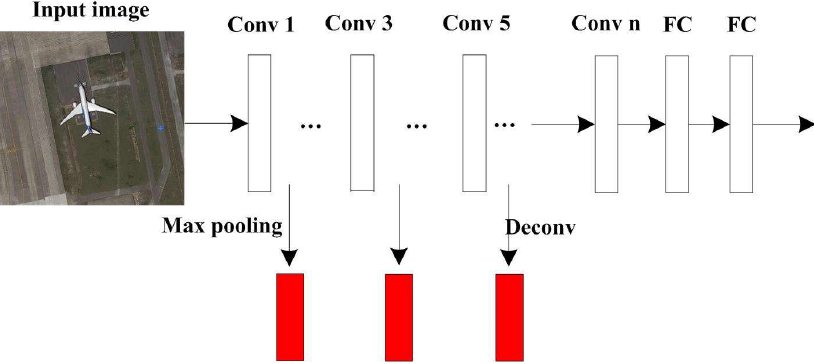
Figure 6. The structure of HyperNet.